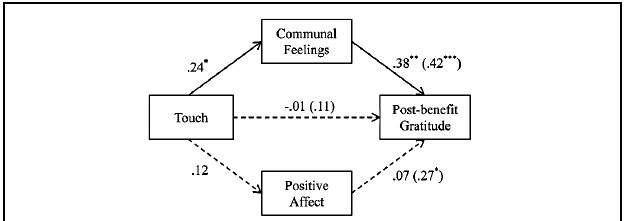
FIGURE 6 | Results of the regression analysis corroborating that the effect of touch on post-benefit gratitude is mediated by communal feelings (vs. positive affect) in Study 2. The numbers are standardized regression coefficients. The numbers outside parentheses represent β -weights when all variables are used concurrently as predictors, whereas the numbers in parentheses are zero-order correlations. ∗ p < 0.05; ∗∗ p < 0.01; ∗∗∗ p <